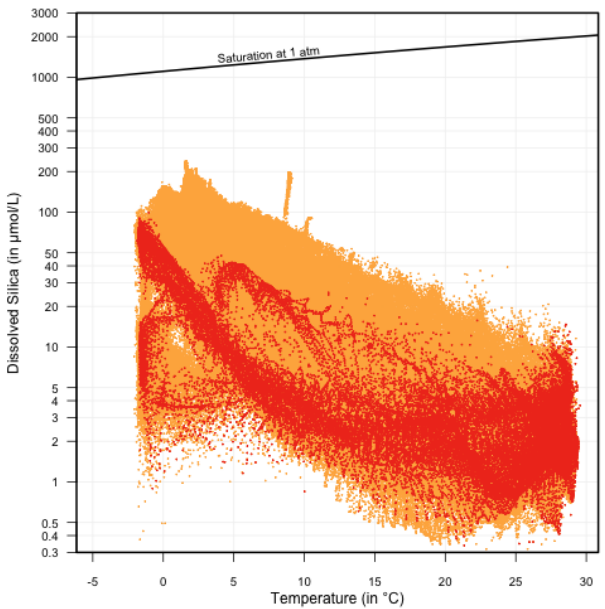
Figure 1. Dissolved silica is undersaturated at all depths. Satura- tion concentration vis-à-vis amorphous silica at 1atm of pressure follows Wollast (1974). It is known to increase with pressure/depth (e.g., Willey, 1974). Red dots correspond to measurements of dis- solved silica (silicic acid) at the surface of the ocean and orange dots at various depths. Both correspond to the complete World Ocean Atlas 2009 dataset (Garcia et al.,